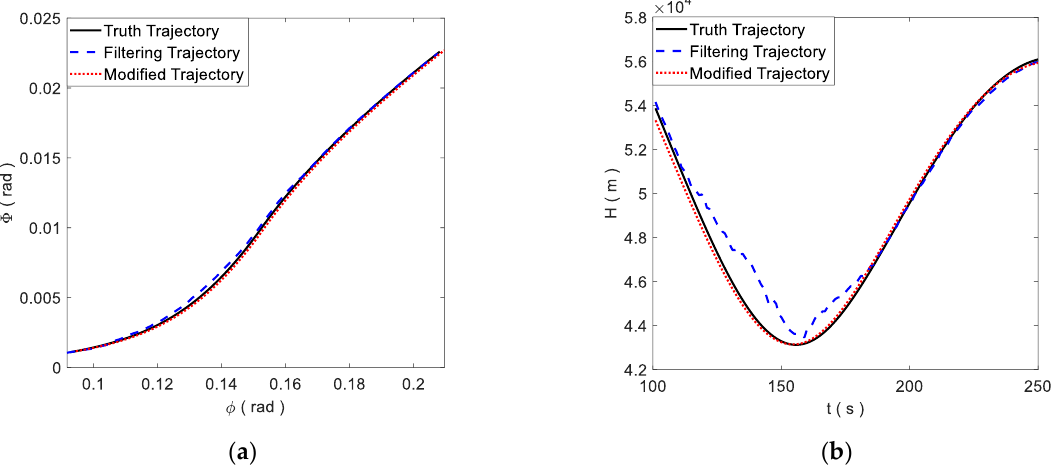
Figure 13. Effect of parameter value network: (a) is the lateral modified filtering trajectory; and (b) is the longitudinal modified filtering trajectory.